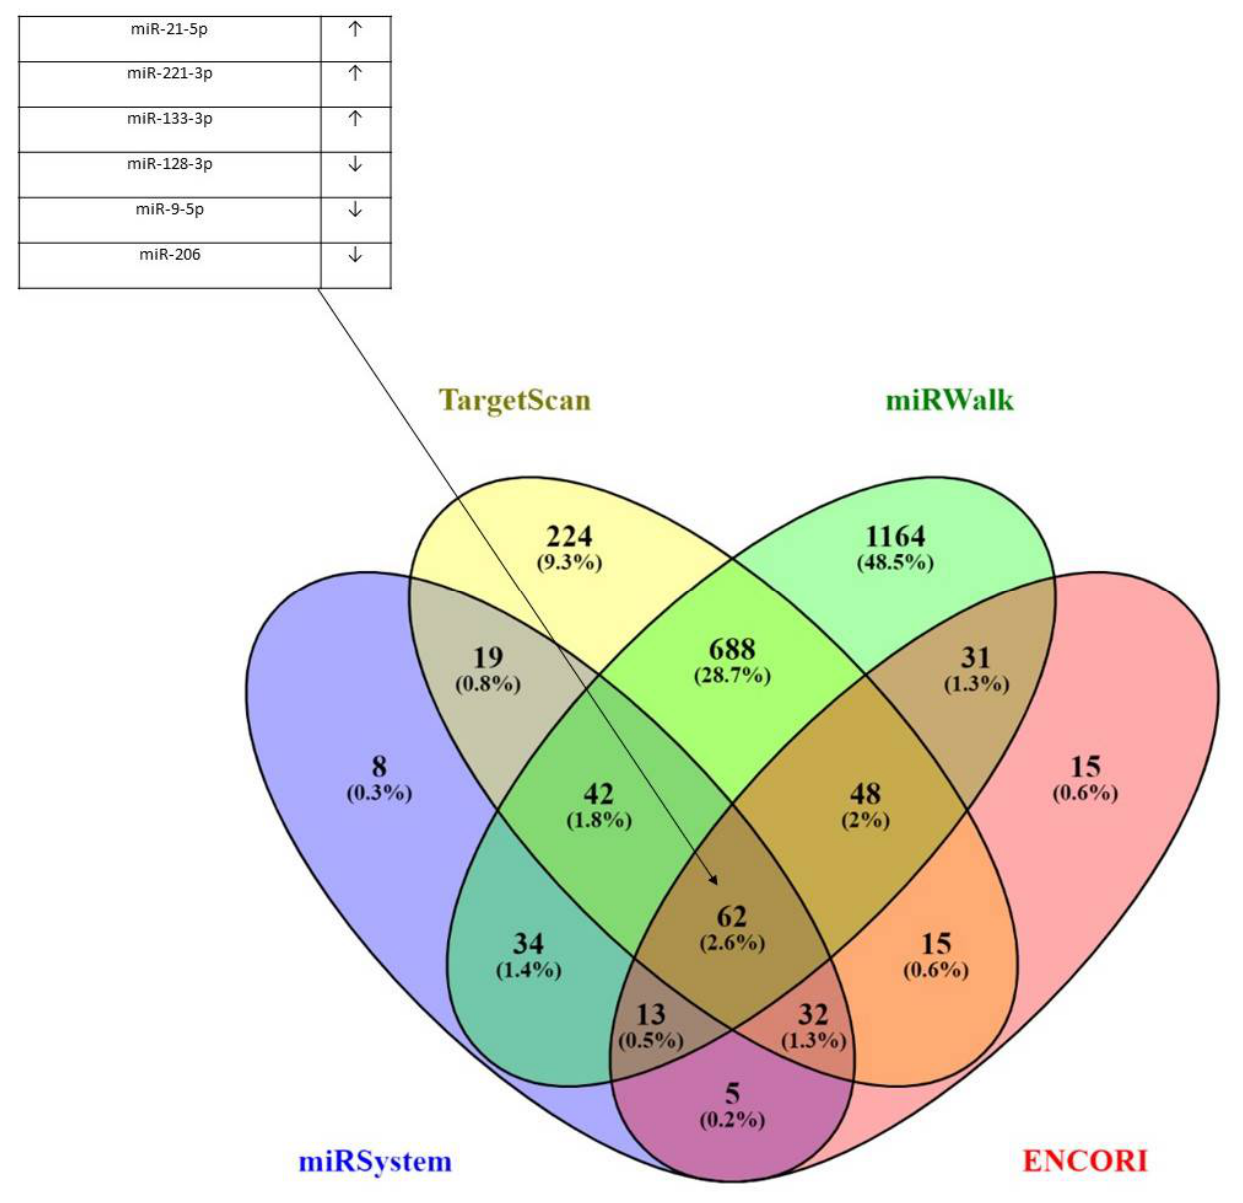
Figure 6. miRNA gene targets for CORO1C and physical interactions of CORO1C and other genes. Venn diagram incorporating miRSystem, TargetScan, miRWalk, and ENCORI databases. In total, 62 miRNAs were found to overlap between the 4 miRNA analysis tools (2.6%). Of these, miR-133-3p, hsa-miR-206, and miR-128-3p have been shown to be associated with CORO1C gene expression in different types of